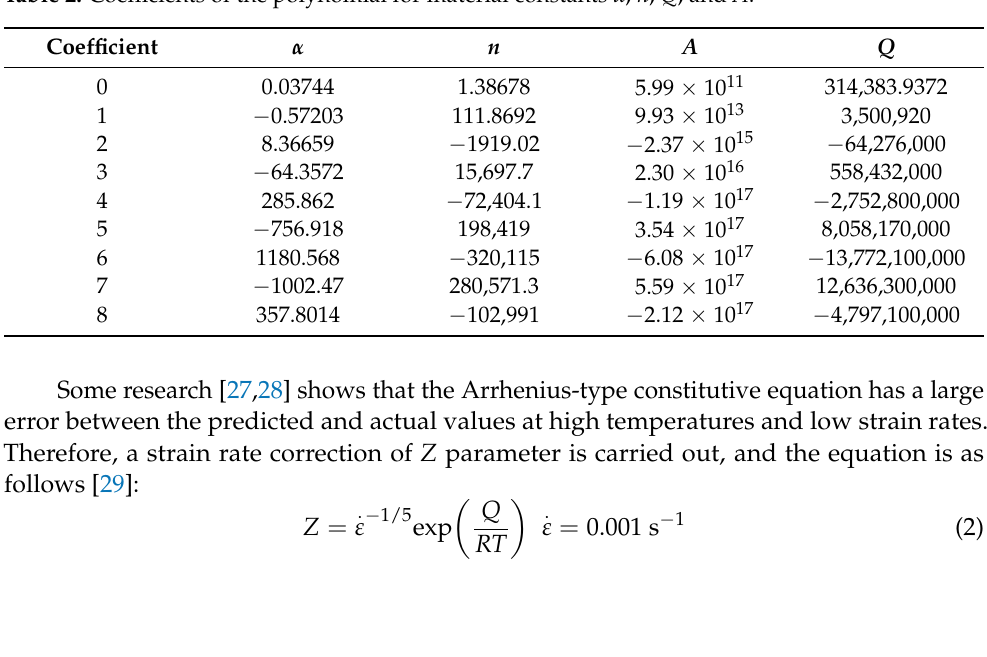
Figure 4. Linear fitting schematic between strain and material constants α ( a ), n ( b ), Q ( c ), and A ( d ). Table 2. Coefficients of the polynomial for material constants α , n , Q , and A